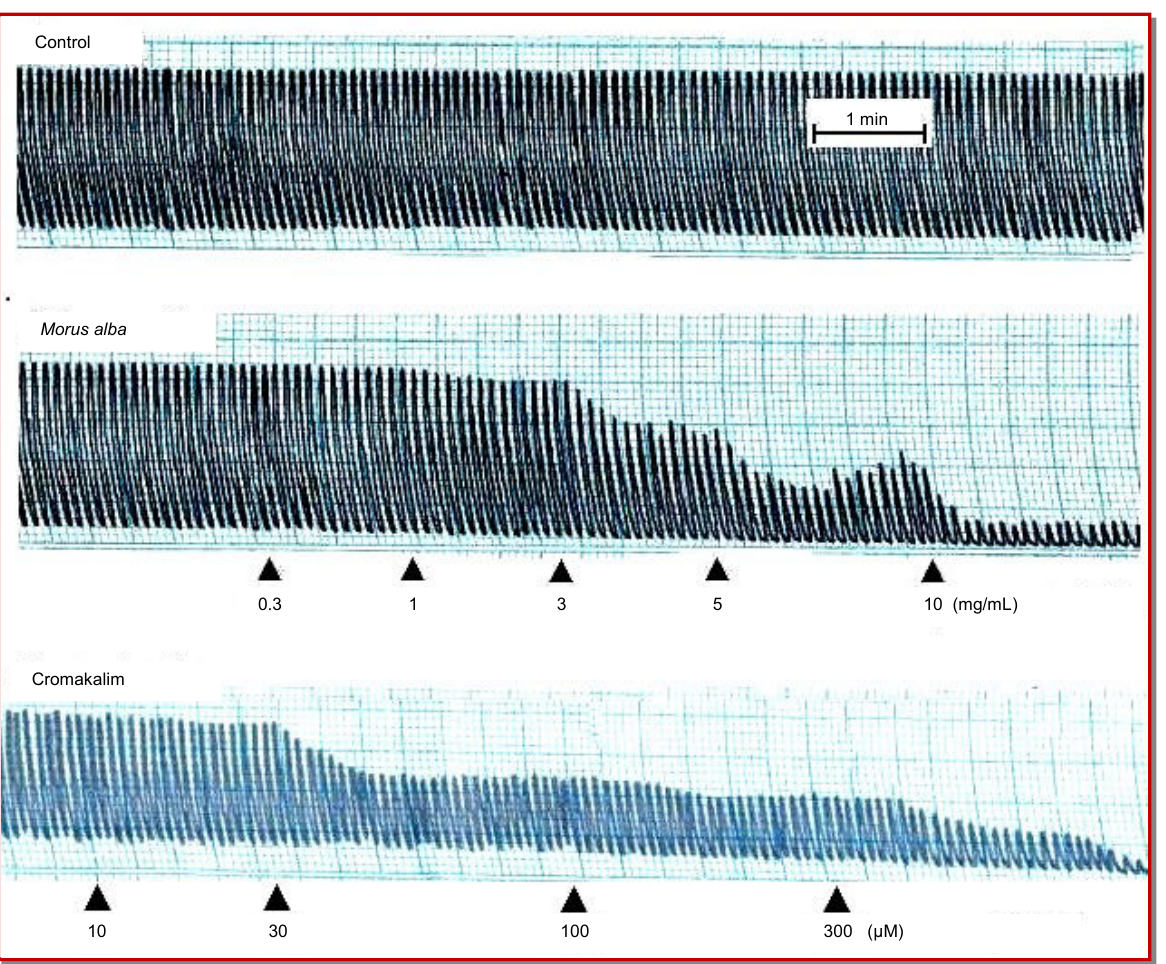
Figure 1: Tracings showing concentration-dependent relaxant effect of the crude extract of Morus alba and cromakalim on spontaneously contracting isolated rabbit jejunum preparations. Test material was added to the tissue bath in cumulative fashion and the concentrations shown are the final bath